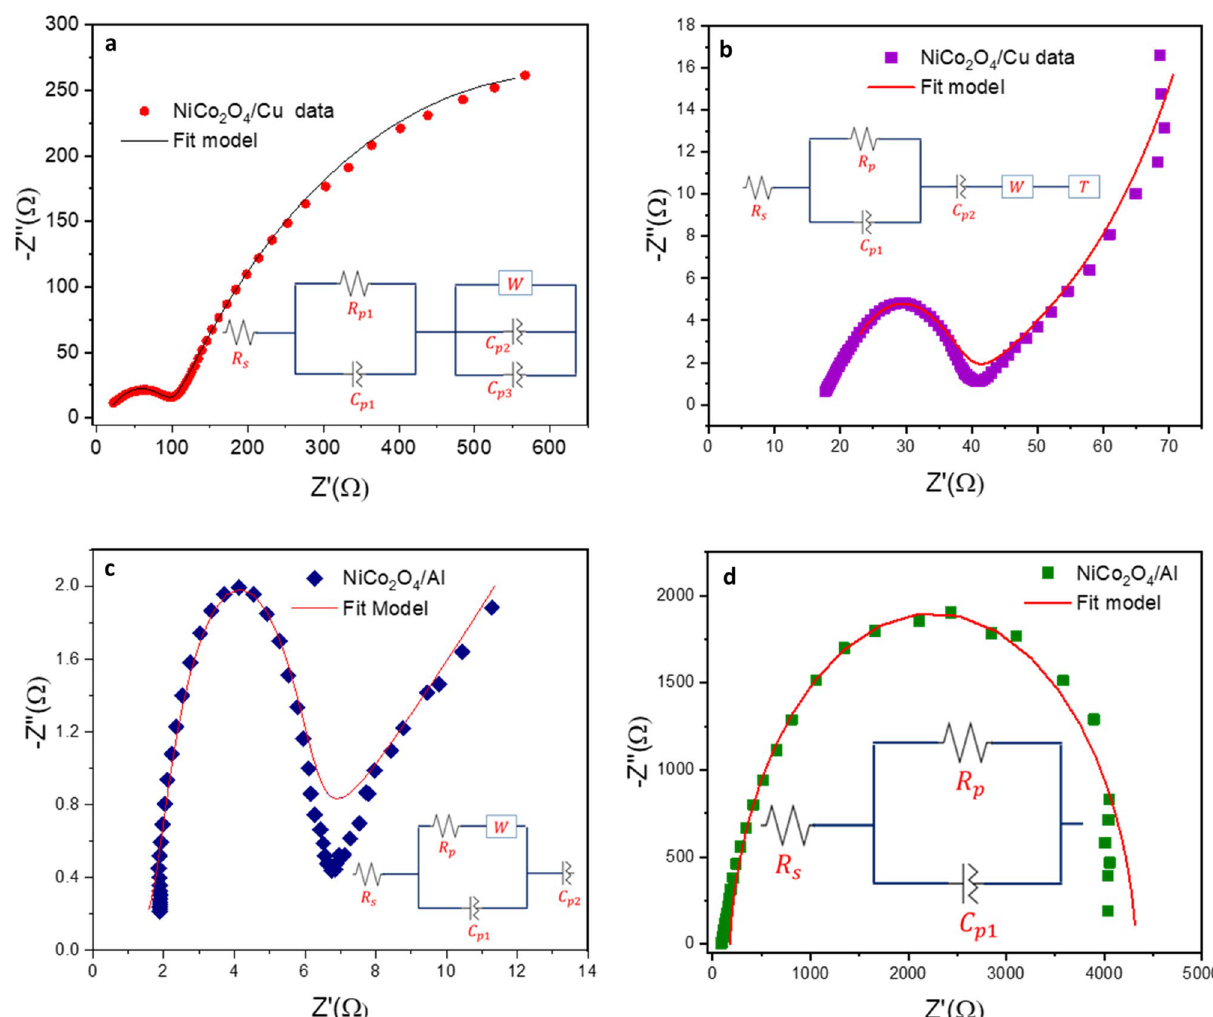
in H SO solution (scan: 10 5 –0.001 Hz), c NiCo 2 4 tion (scan: 10 5 –0.1 Hz), and d NiCo O / 2 4 10 5 –0.1 O /Cu 2 4